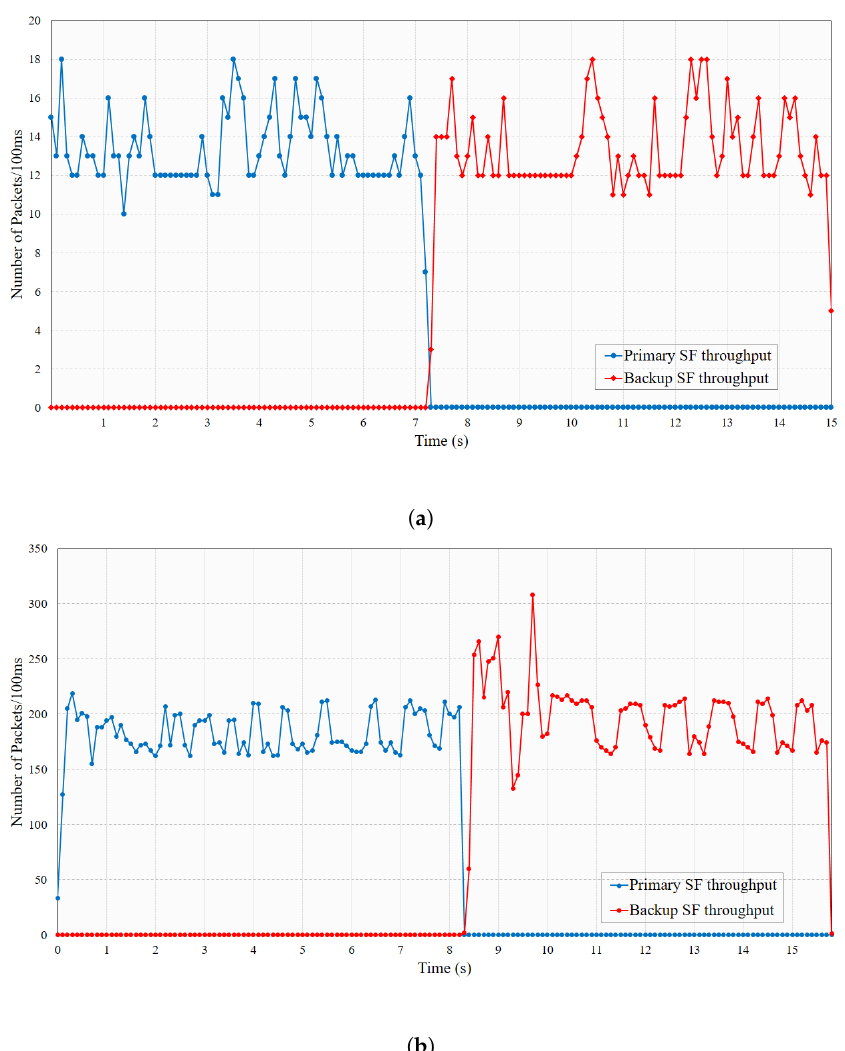
Figure 5. Network traffic recovery delay for single SF chain incurred by HP-SFC in the data center and enterprise topologies. ( a ) Throughput at the primary SF ( f 1 ) and backup SF ( f (cid:48) center topology. ( b ) Throughput at the primary SF ( f 1 ) and backup SF ( f (cid:48)